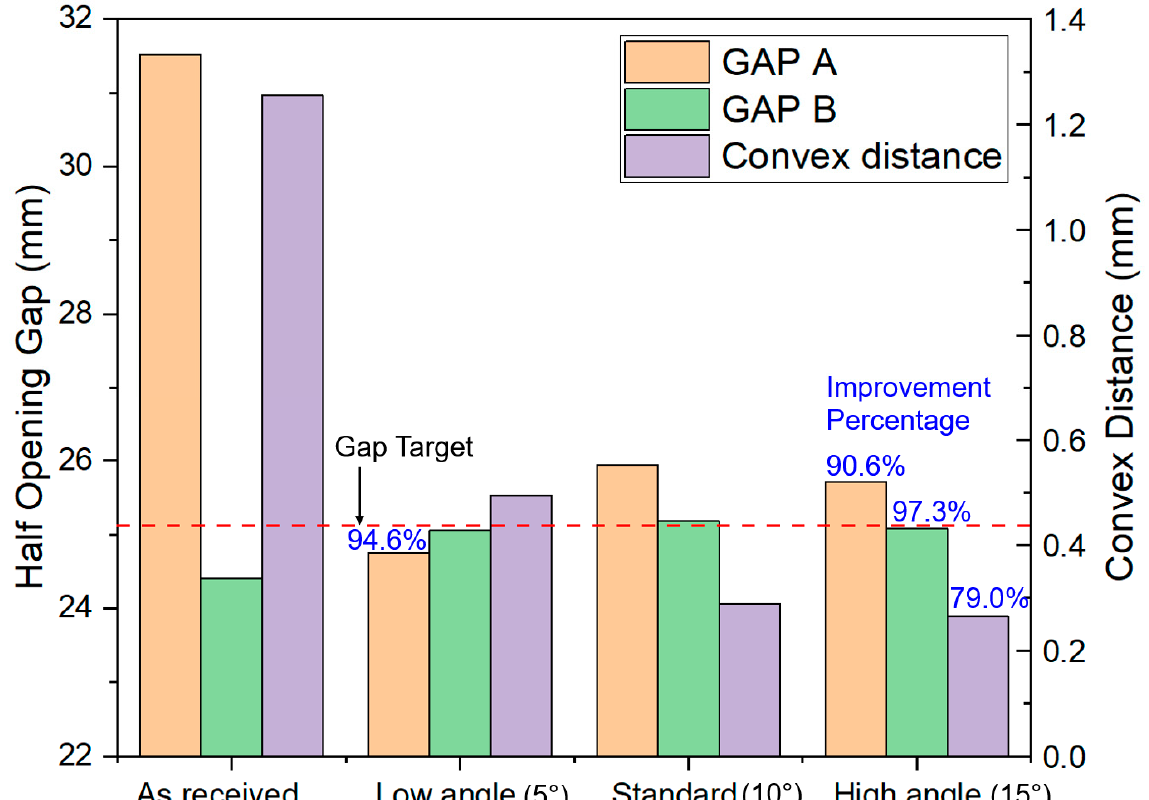
Figure 12. Comparison of the final dimensions of the profiles under different wedge angles.